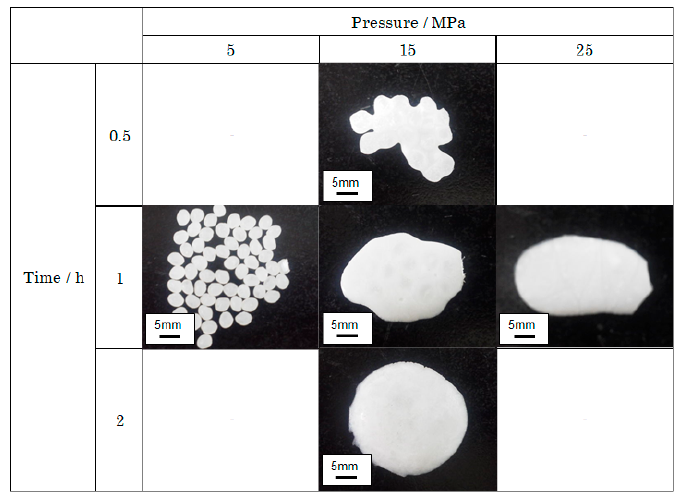
Figure 2. Appearance of PLLA pellets after supercritical treatment.